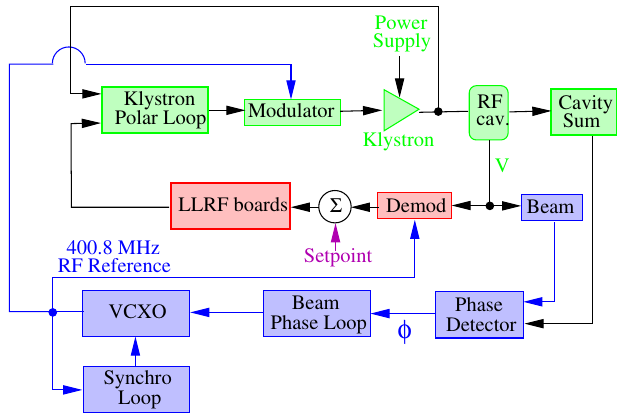
FIG. 1. Simplified block diagram of the rf system with beam phase